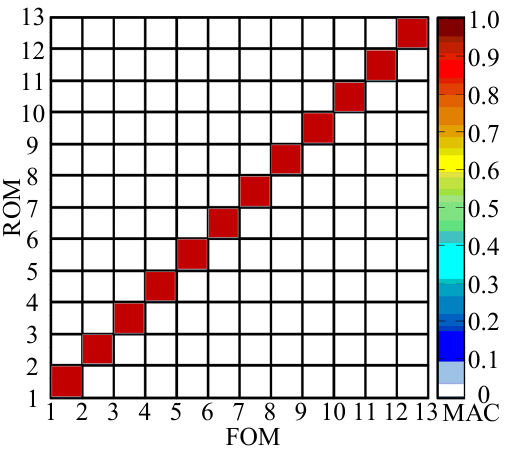
Figure 6. The model assurance criterion (MAC) of the mode shapes obtained from the ROM and the FOM.